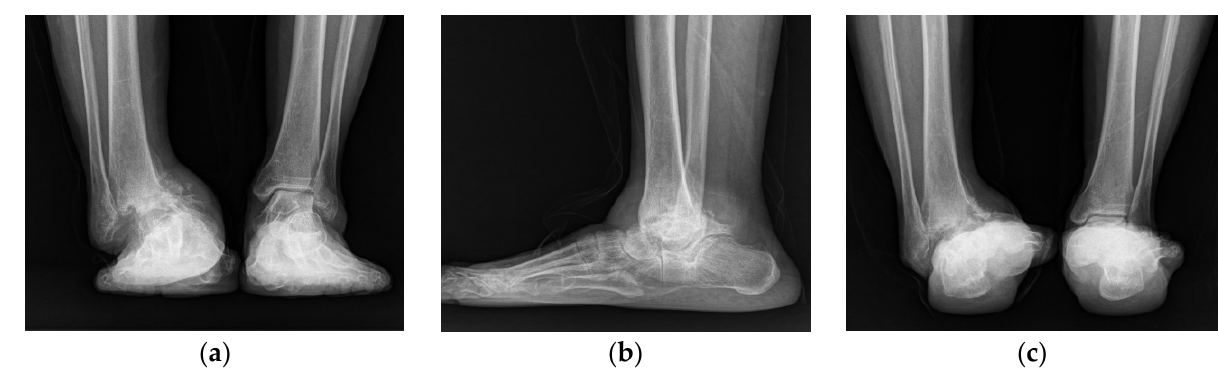
Figure 2. Plain anteroposterior ( a ), lateral ( b ), and heel alignment ( c ) radiographs showing an ankle with severe varus deformity, and osteoarthritic changes with destruction of the tibiotalar joint.